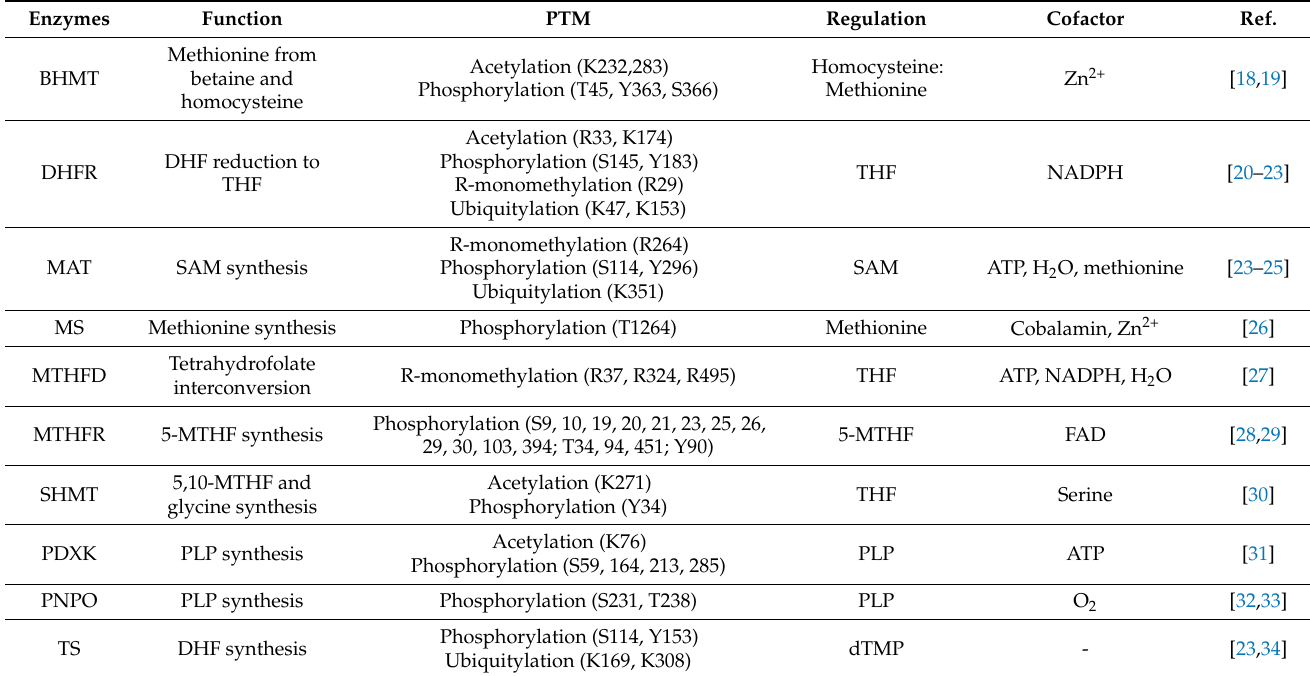
Table 1. One carbon metabolic enzymes are regulated by post-translational modifications and cofactor